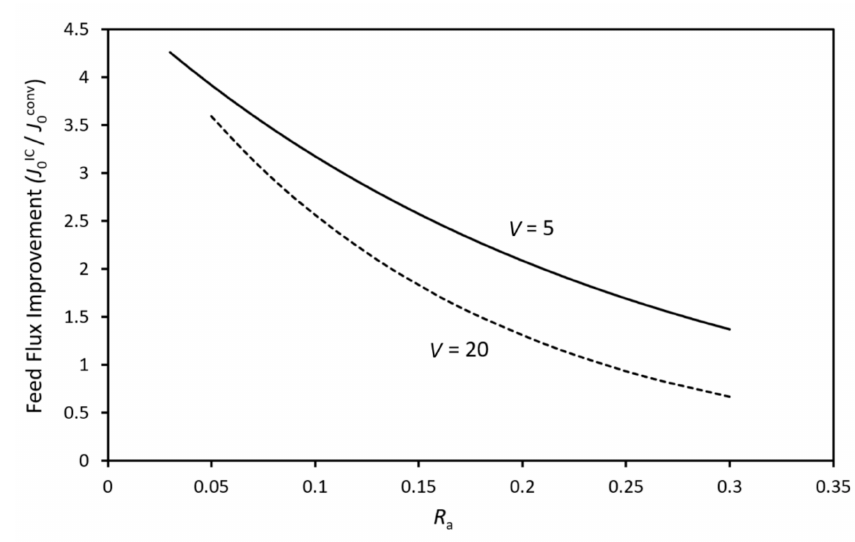
Figure 5. Improvement in feed flux achieved using the IC, relative to conventional operation, plotted vs. adsorptive recovery obtained. These profiles are obtained from the curve fits in Figure